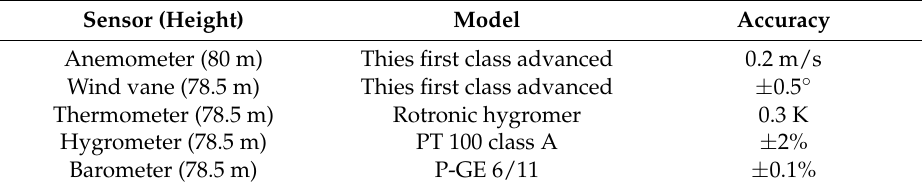
Table 5. Specification of sensors on the met